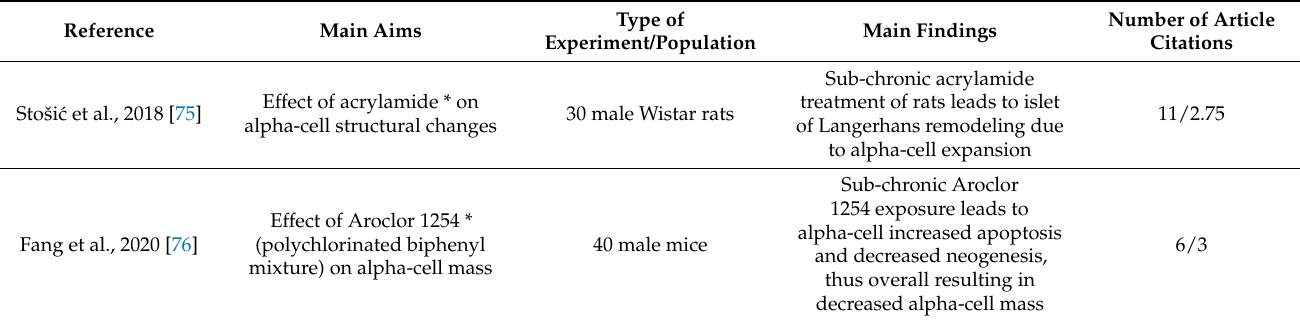
Table 1. Summary information related to the studies concerning the effects on the alpha cell of various chemical/biological compounds. The number of citations (total/per year) is from SCOPUS (last checked: 30 September